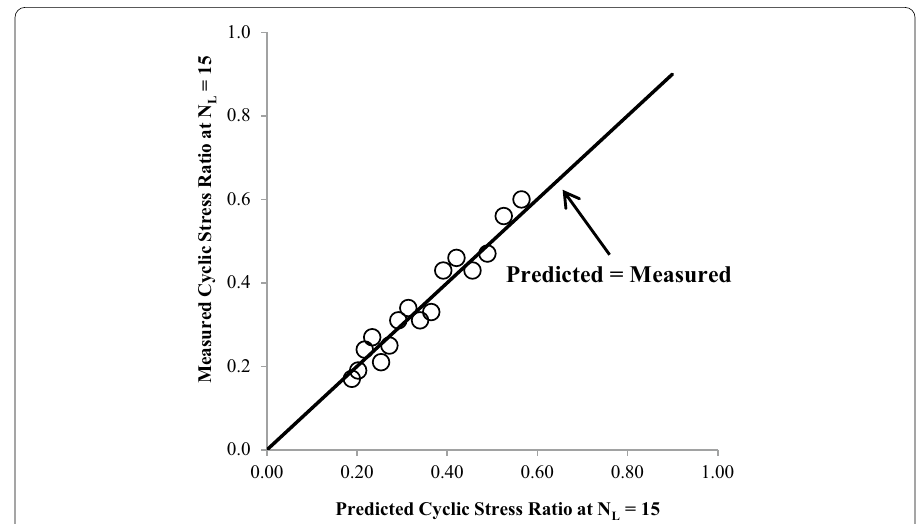
Fig. 16 Comparison of observed cyclic strength value form cyclic triaxial test with predicted cyclic strength value of Digha sand which induces liquefaction after 15